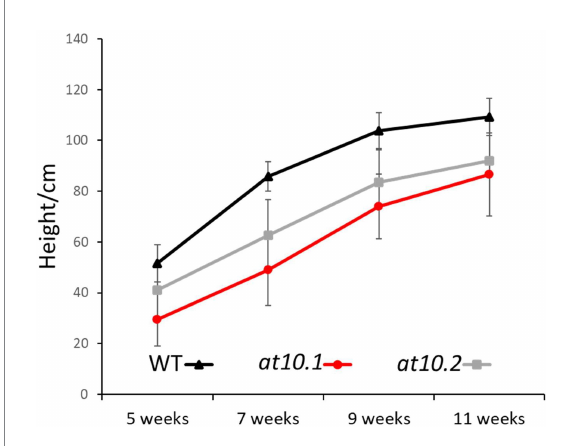
FIGURE 2 Growth of rice plants studied. Total height was measured at different stages of growth. Wild Type (Black), OsAT10.1 (Gray) and OsAT10.1 (Red). Error bars represent standard